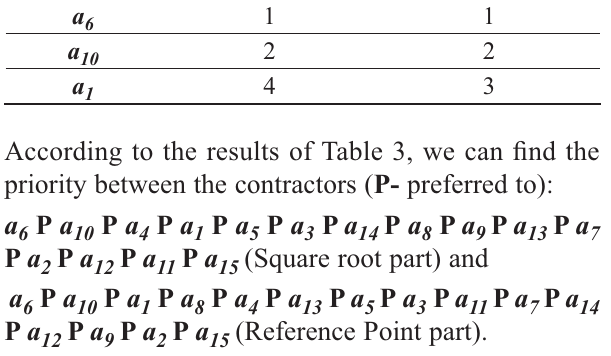
Table 4. No discussion on the ranking of the fi rst three positions